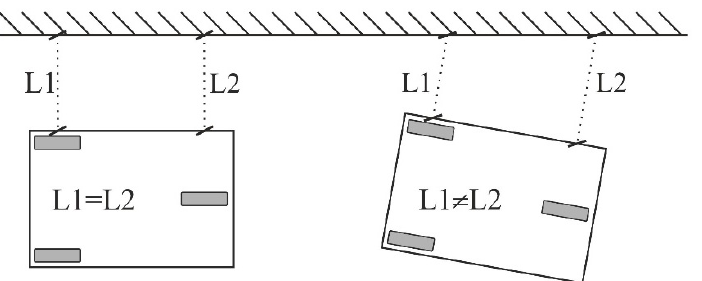
Figure 5. Parallel and non-parallel alignments of the AGV with respect to the reference surface.